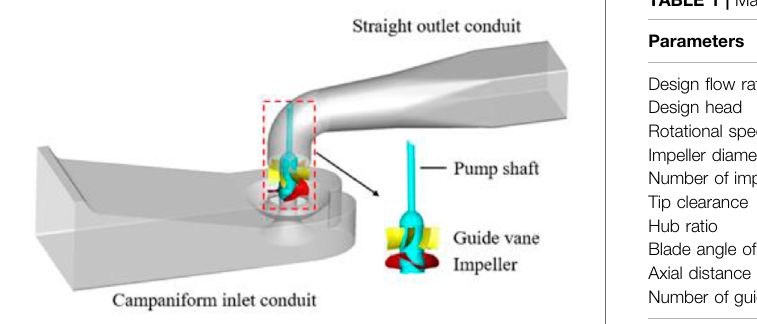
TABLE 1 | Main parameters of the pump